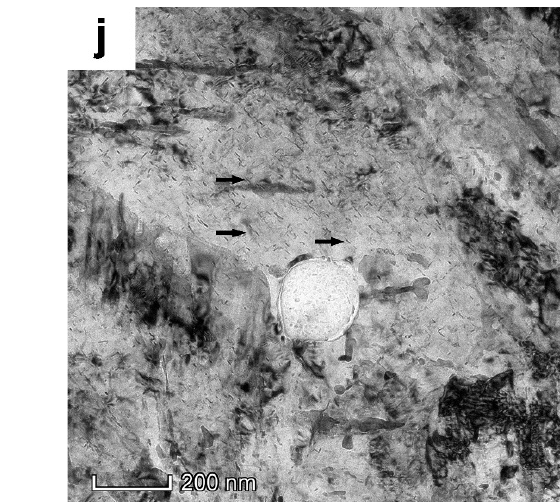
Figure 3. Morphology of Dievar steel after tempering at different temperatures for various time periods: ( a ) 550 °C for 4 h; ( b ) 550 °C for 24 h; ( c ) 600 °C for 4 h; ( d ) 600 °C for 16 h; ( e ) 600 °C for 24 h; ( f ) 650 °C for 4 h; ( g ) 650 °C for 16 h; ( h / i ) 650 °C for 24 h; ( j ) 600 °C for 4 h (TEM). Table 3. Lath size variation in different tempering